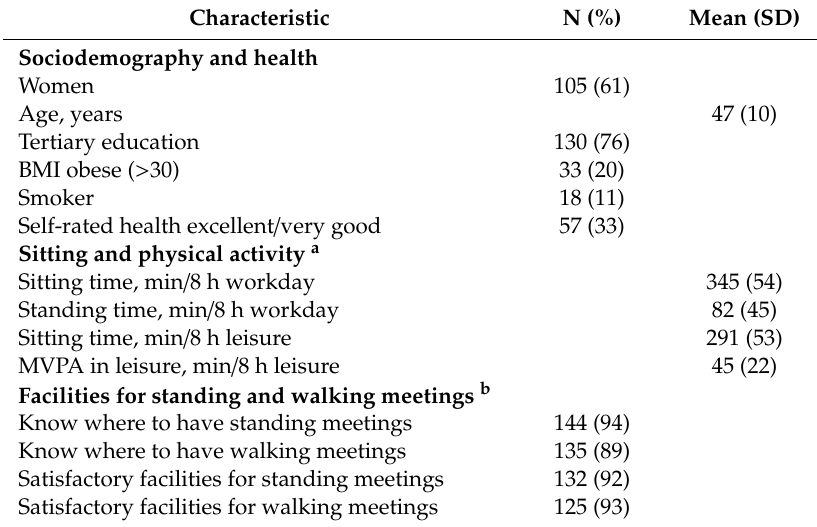
Table 1. Participant characteristics at baseline ( n =